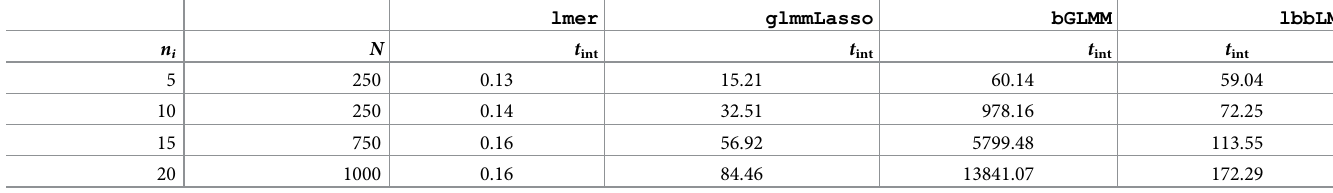
with τ = 0.4 and p = 10 i